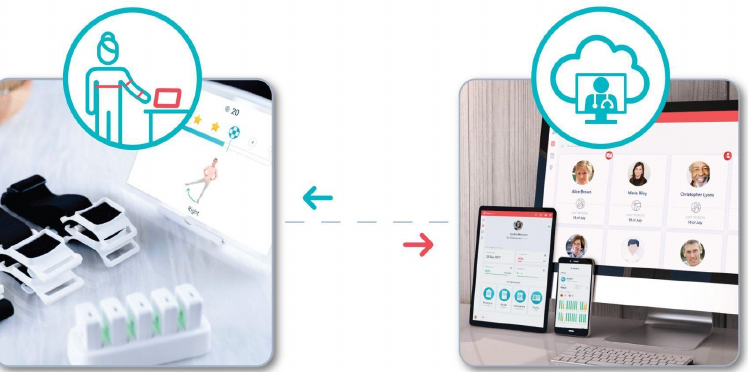
Figure 1. System components. The left figure shows the motion tracker setup and the mobile app displaying the audio-video instructions during the exercise, alongside the real-time biofeedback provided to patients. The right figure depicts the web portal with the results from each patient’s session, enabling fully remote asynchronous monitoring by the assigned physical